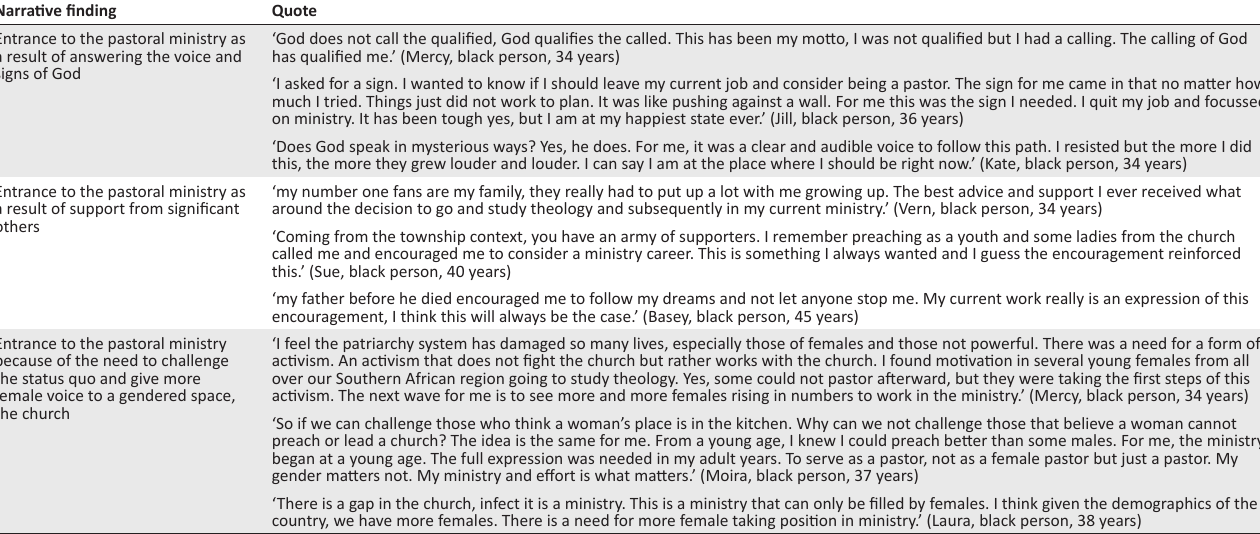
TABLE 1: Narratives and quotes of female pastors ( n = 10). Narrative finding